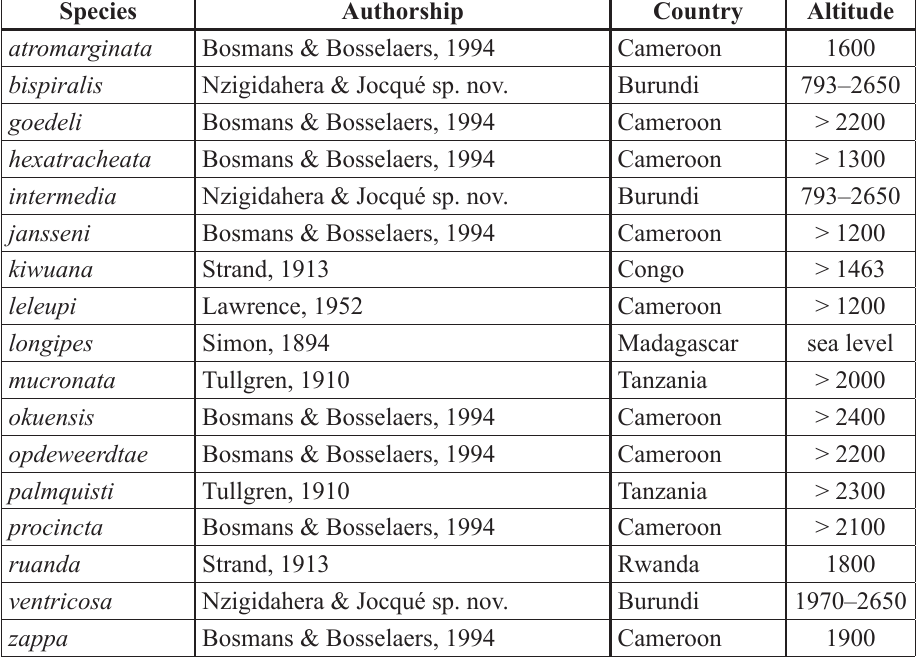
Table 1. altitude distribution of Pachygnatha Sundevall,